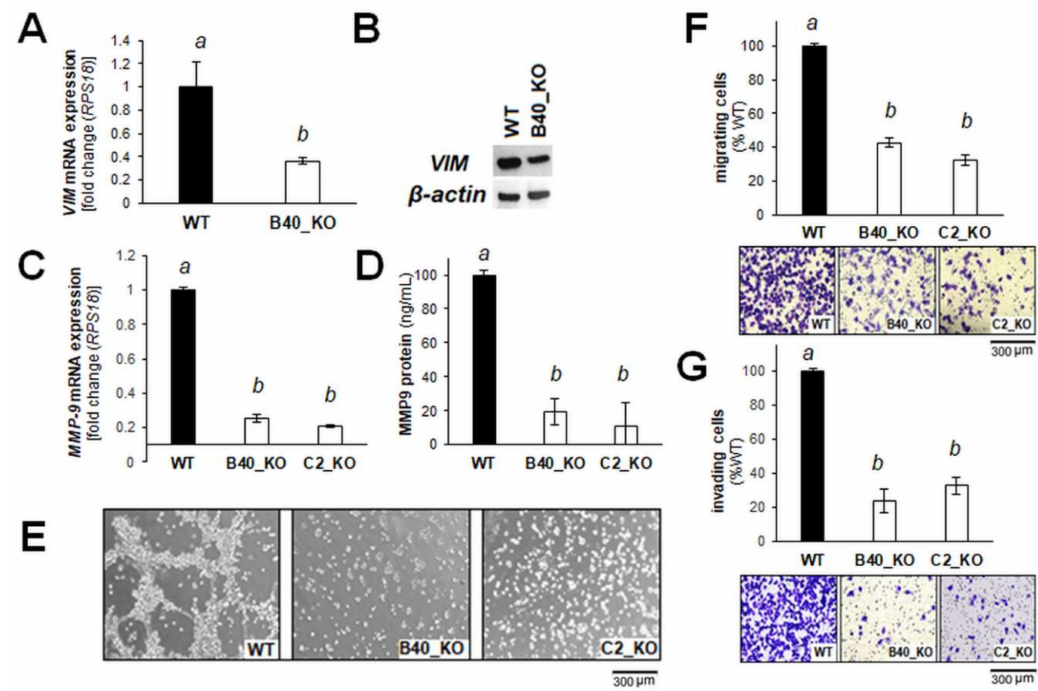
Figure 4. Genomic GLO1 deletion impairs migration and invasion of A375 malignant melanoma cells. ( A ) RT-qPCR and ( B ) immunoblot assessment of vimentin expression (WT, B40_KO). ( C )